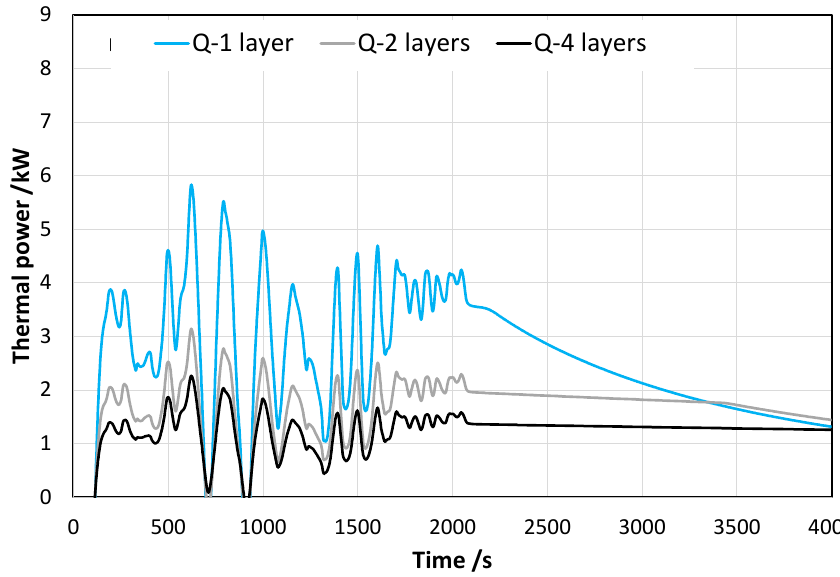
Figure 6. Thermal power during charging for different numbers of stacked PCM layers.